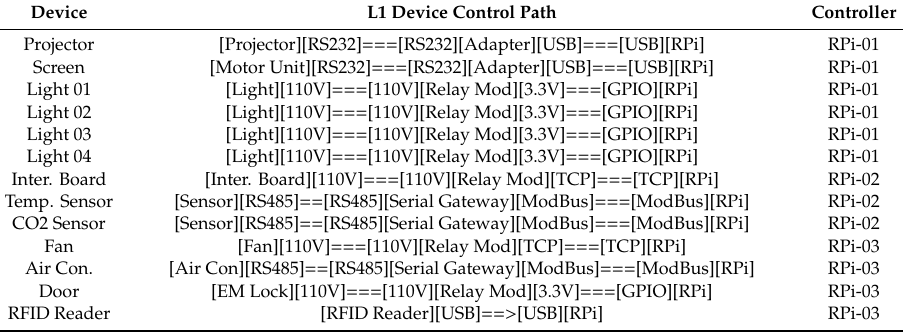
Table A1. Connections between controlled devices and Raspberry Pi boards in layer